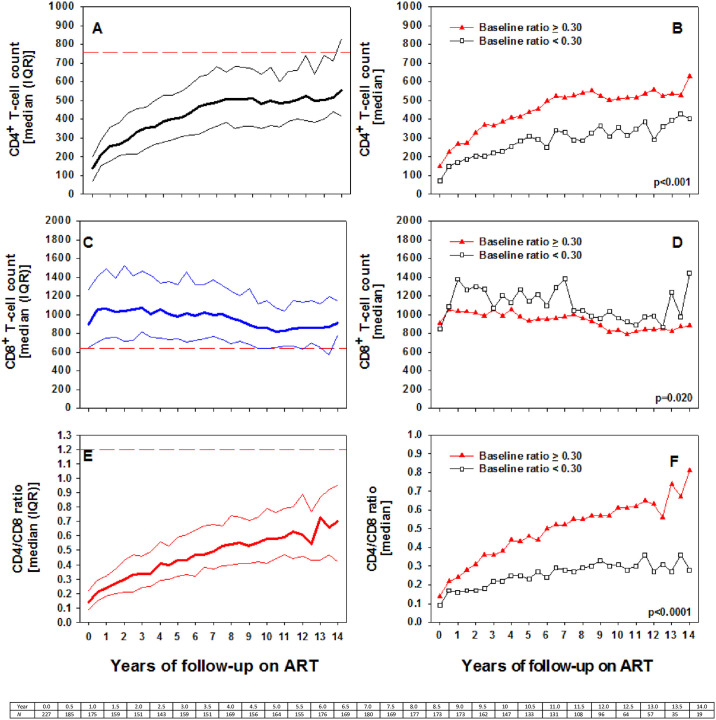
Trends in CD4+ T-cell (A), CD8+ T-cell (C) counts and CD4/CD8 ratio (E) among all patients with virologically suppressive ART, or trends in CD4+ T-cell (B), CD8+ T-cell (D) counts and CD4/CD8 ratio (F) in those stratified by baseline ratio < 0.30 or ≥ 0.30.Data represent median (IQR) for A, C and E, or as median only for B, D and F. Dashed horizontal lines across figures A, C and E represent normal reference threshold values in healthy Ethiopians [34].